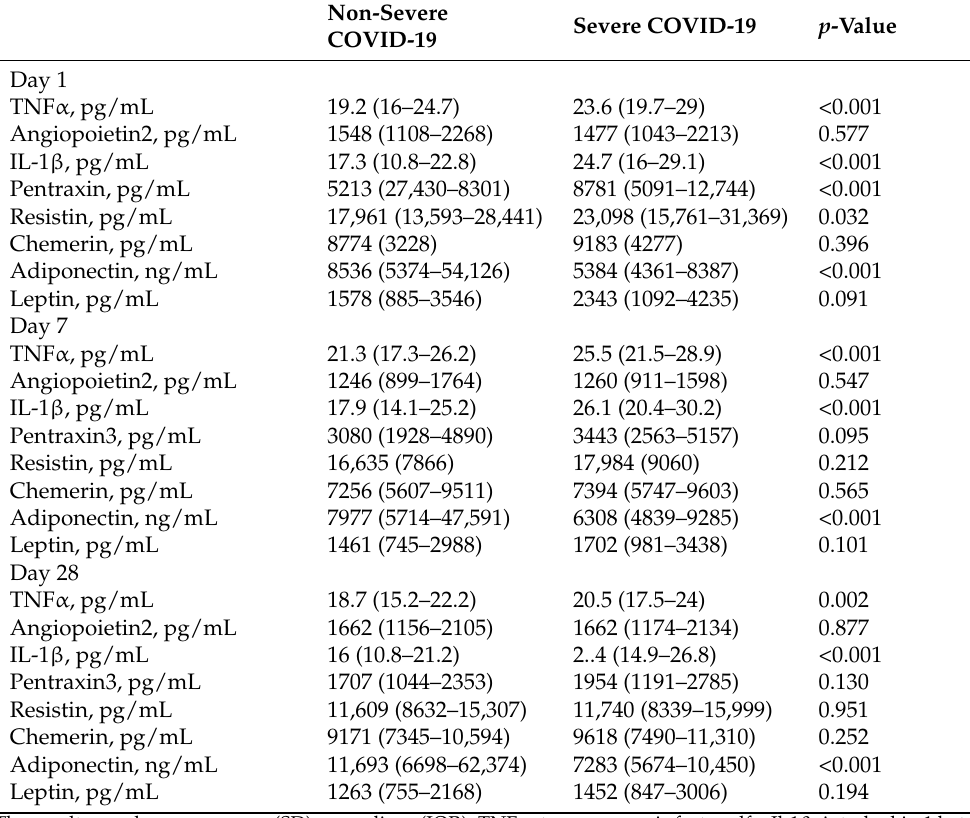
Table 2. Serum biomarkers in patients with COVID-19 according to the severity of infection.